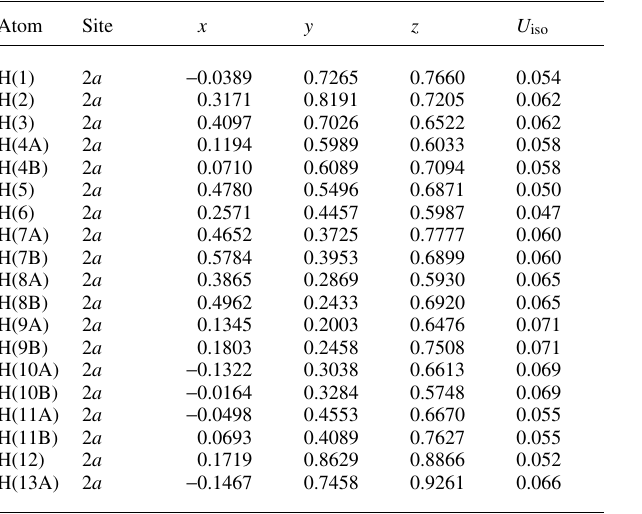
Table 2. Atomic coordinates and displacement parameters (in Å 2 )